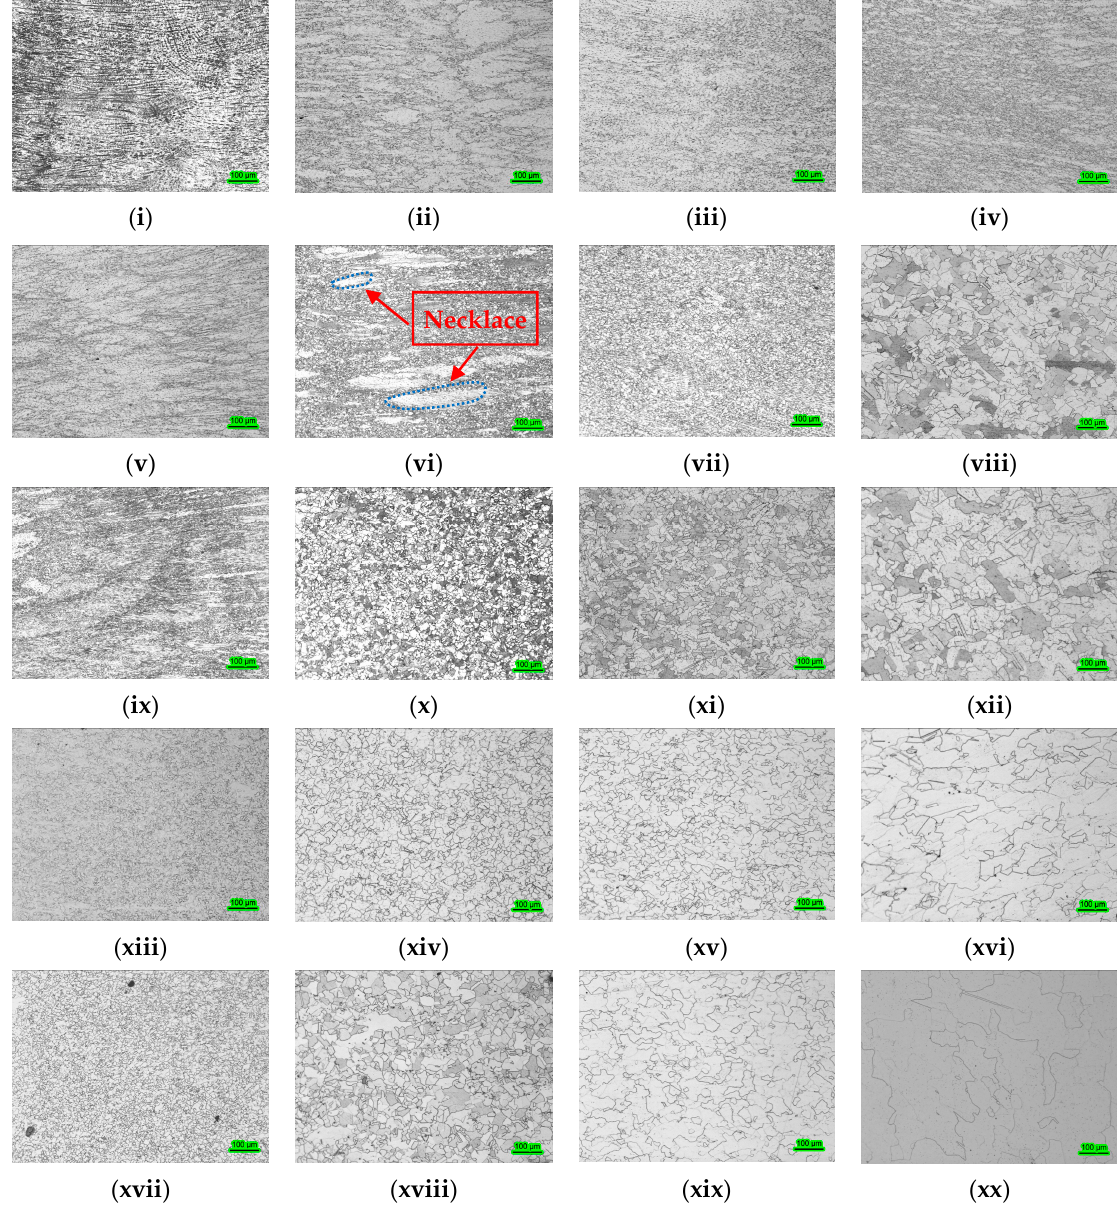
Figure 14. Typical microstructures of PM/Wrought dual superalloy processed after hot compression.